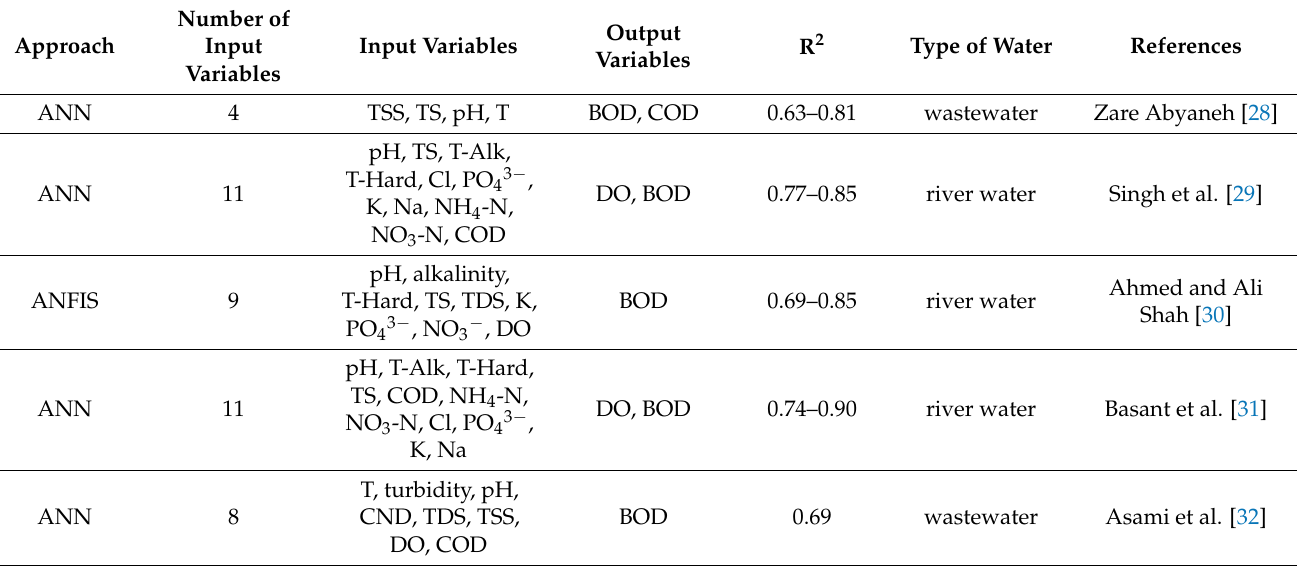
Table 2. Approaches for estimating BOD, input, output variables and correlation coefficient (R 2 ) for each